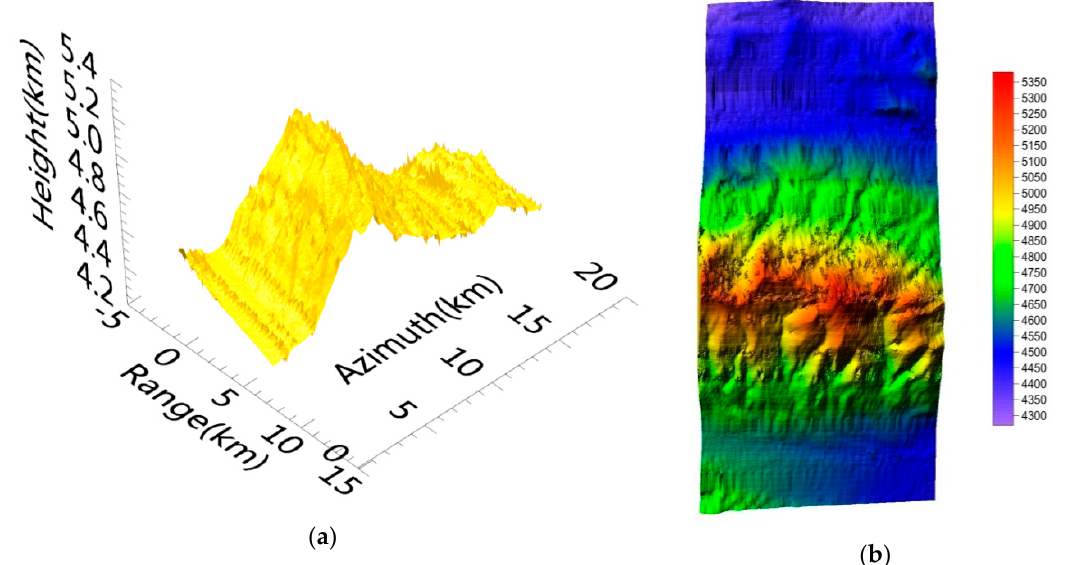
Figure 8. Gaofen-3 DEM after geolocation. ( a ) Gaofen-3 DEM in imaging coordinates; ( b ) top view of the Gaofen-3 DEM (m).